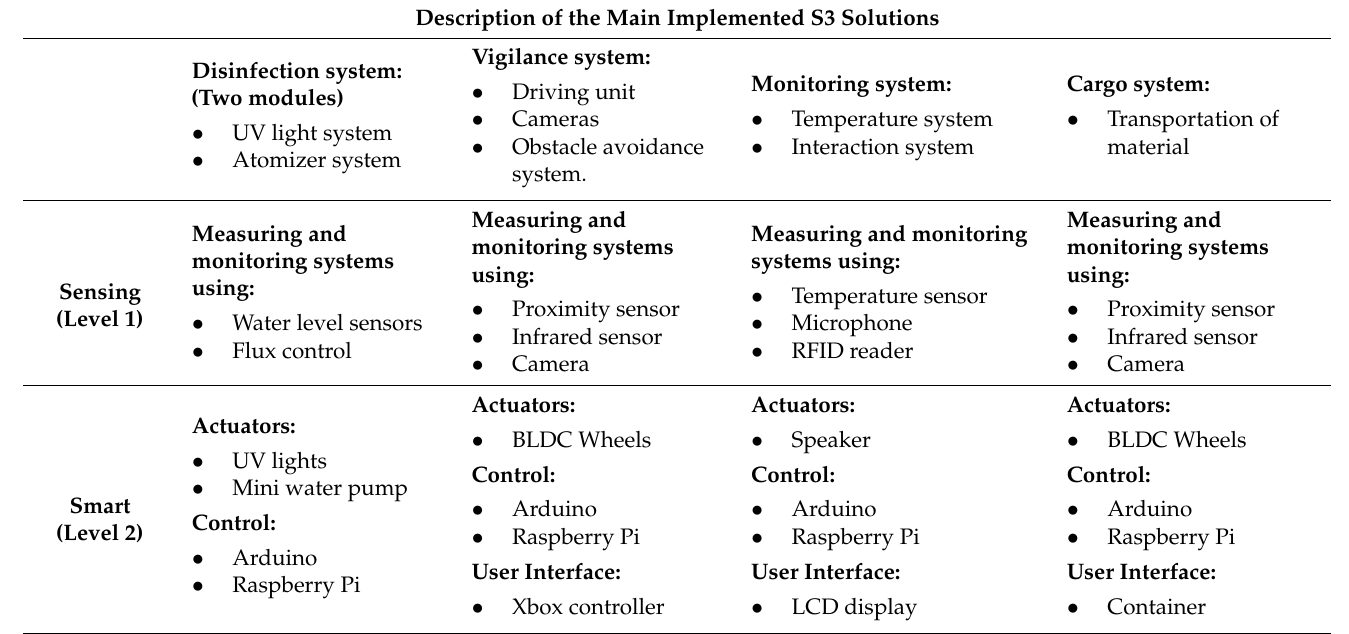
Table 4. S3 solution according to the implemented modules in the ROBOCOV